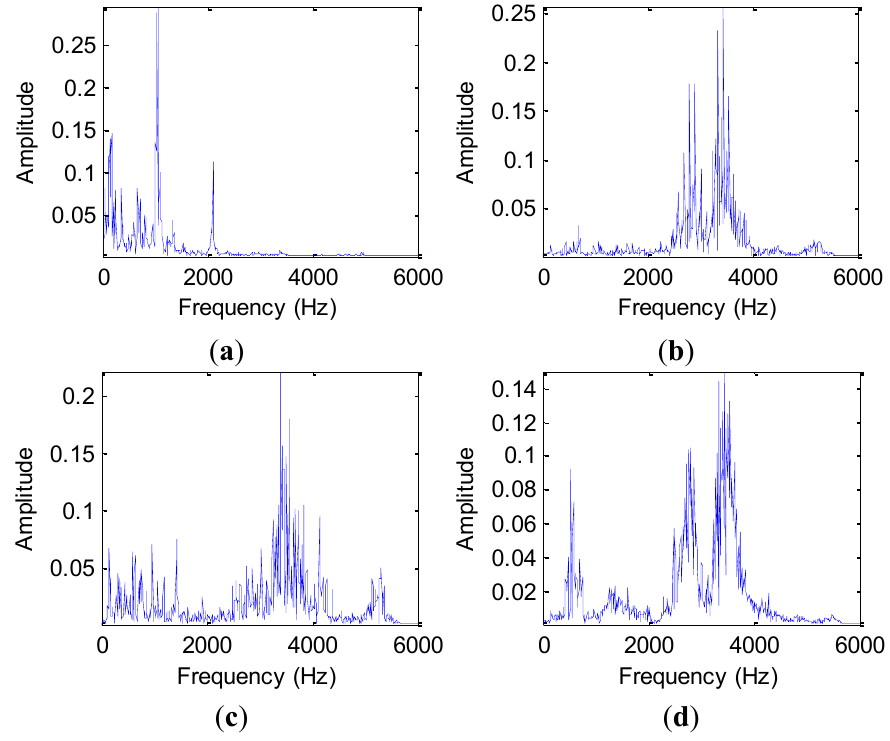
Figure 8. The single-sided amplitude spectrum based on FFT in the D_ORF dataset: ( a ) the normal bearing. ( b ) ORF07 bearing. ( c ) ORF14 bearing. ( d ) ORF21